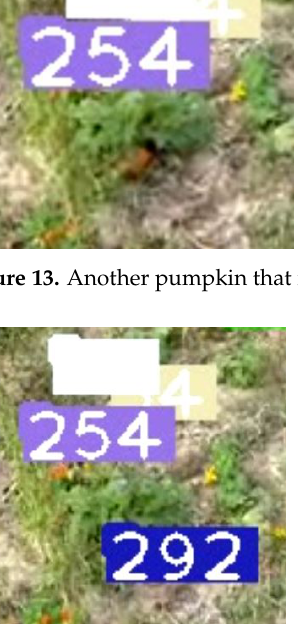
Figure 14. The change in view as the drone flies forward allows more of the pumpkin to be seen, thus is successfully detected and given a track ID.